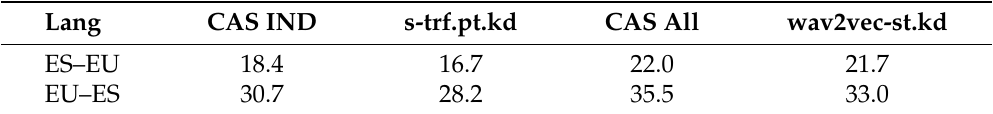
Table 13. BLEU scores on manual evaluation samples.